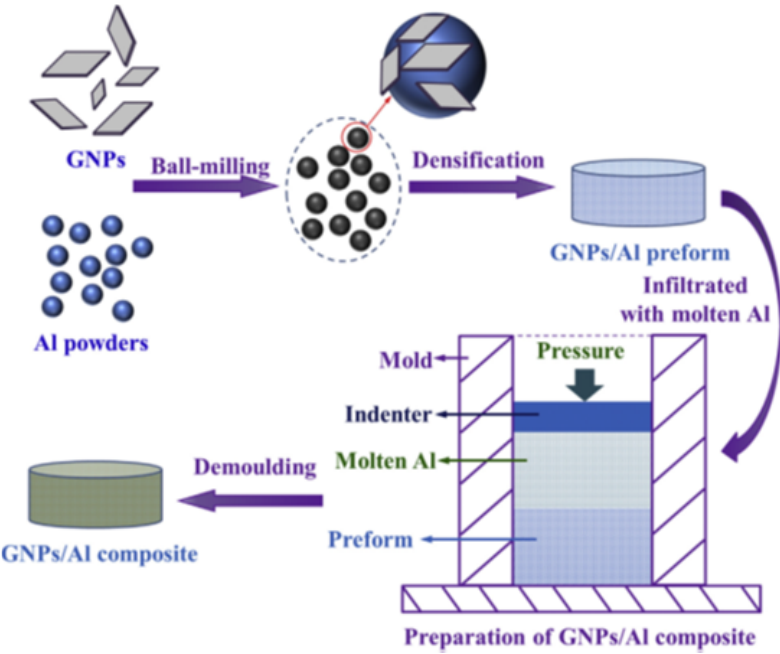
Figure 15: The schematic preparation process of the GNP-Al composites via the pressure infiltration method. Reproduced from Reference